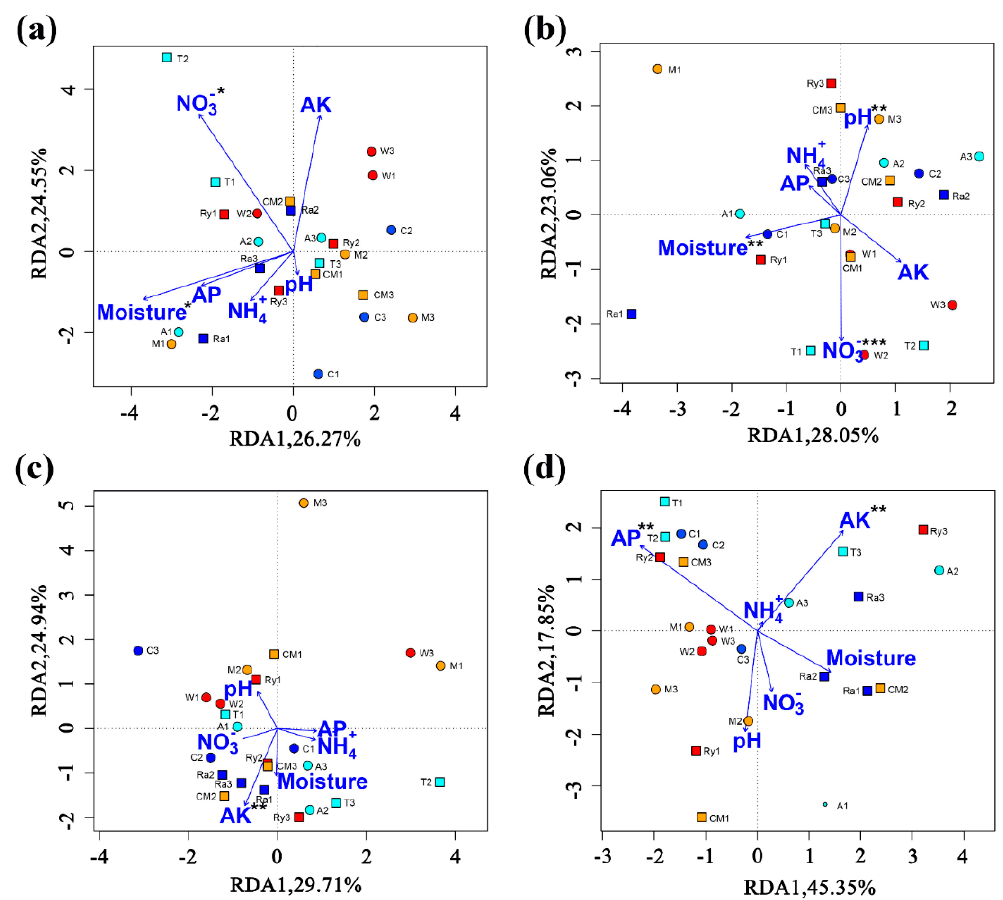
Figure 6. Redundancy analysis (RDA) demonstrating the relationships between soil environmental factors and soil AOA and AOB communities in spring ( a , b ) and autumn ( c , d ). A—alfalfa; T—trifolium; W—wheat; Ry—rye; C—chrysanthemum; Ra—rape; M—mustard; CM—cucumber monoculture. * p < 0.05, ** p < 0.01, *** p < 0.001.